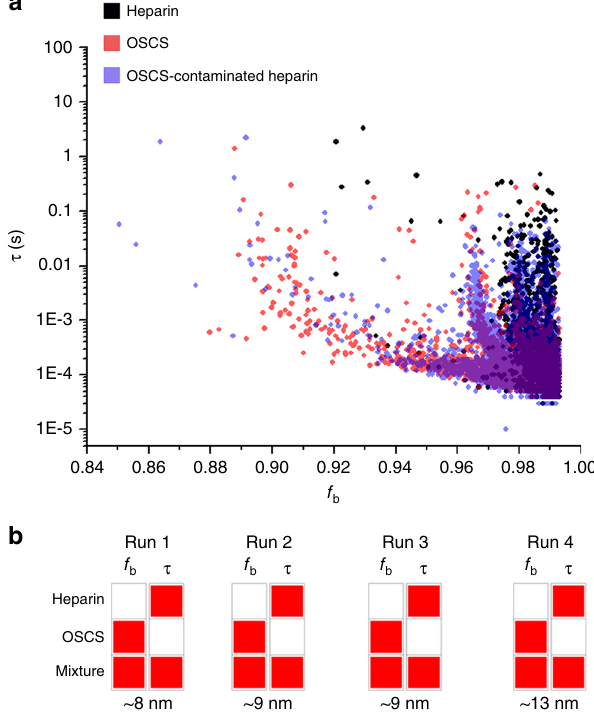
Fig. 5 Nanopore resistive-pulse analysis of heparin, OSCS, and their mixture. a Superimposed scatter plots of 16 ppm heparin, OSCS and OSCS- contaminated heparin added to 4 M potassium chloride at + 200 mV and measured using a ~13 nm pore. The colors in the legend correspond to the listed sample, and are blended (using transparency) in the plot where events from different samples overlap. b Recognition fl ags of heparin, OSCS and their mixture from four independent trials accurately identify the presence of the OSCS aliquot in the mixture. The red squares denote recognition of a species from the distribution of the corresponding